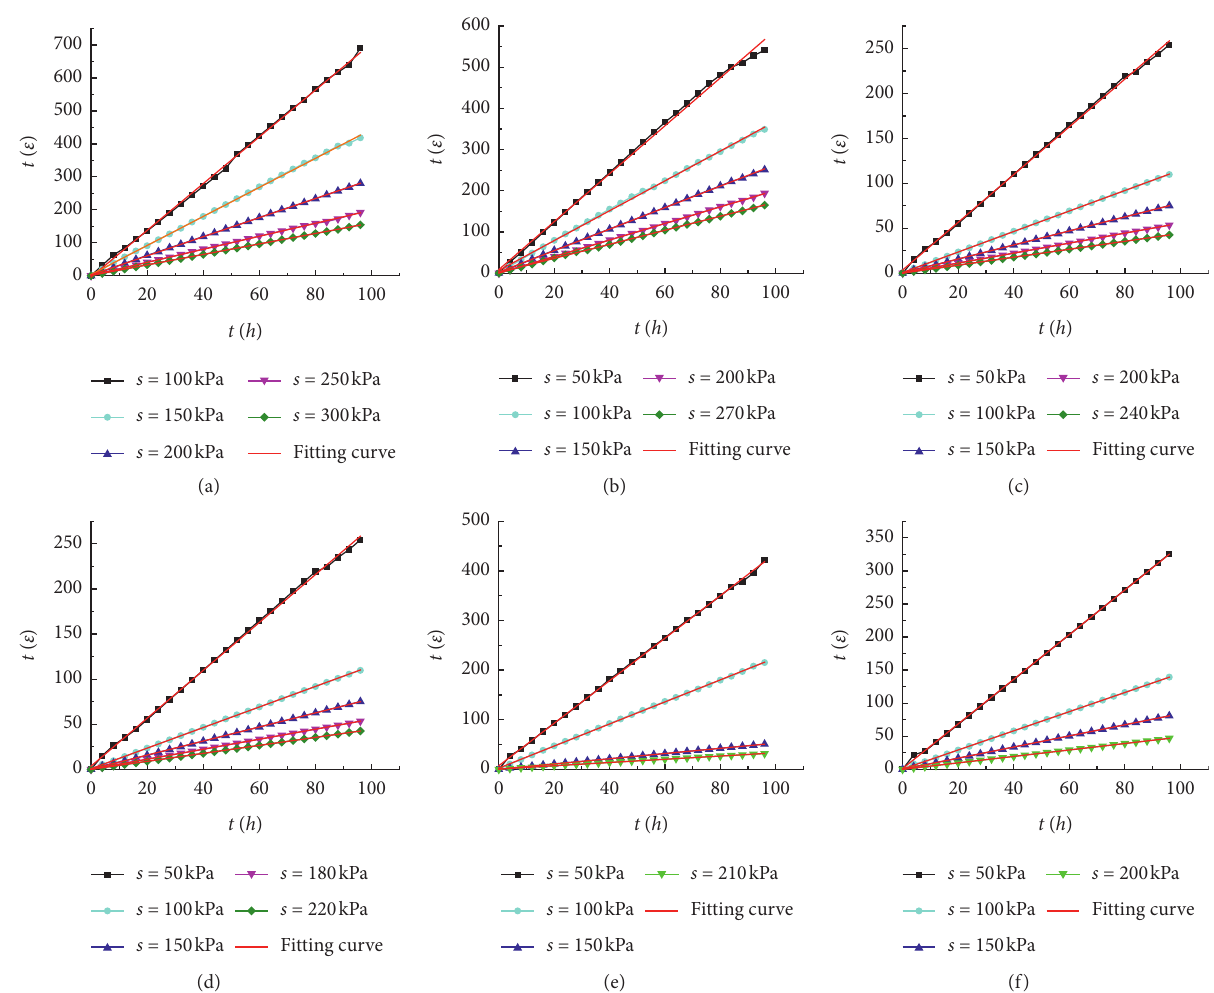
Figure 6: Curves between t / ε and t under different numbers of dry-wet cycles. (a) n � 0, (b) n � 1, (c) n � 3, (d) n � 5, (e) n � 7, and (f) n � parameter C under different dry-wet cycles also changes 1 little, so the final average value of parameter C 0.6478.